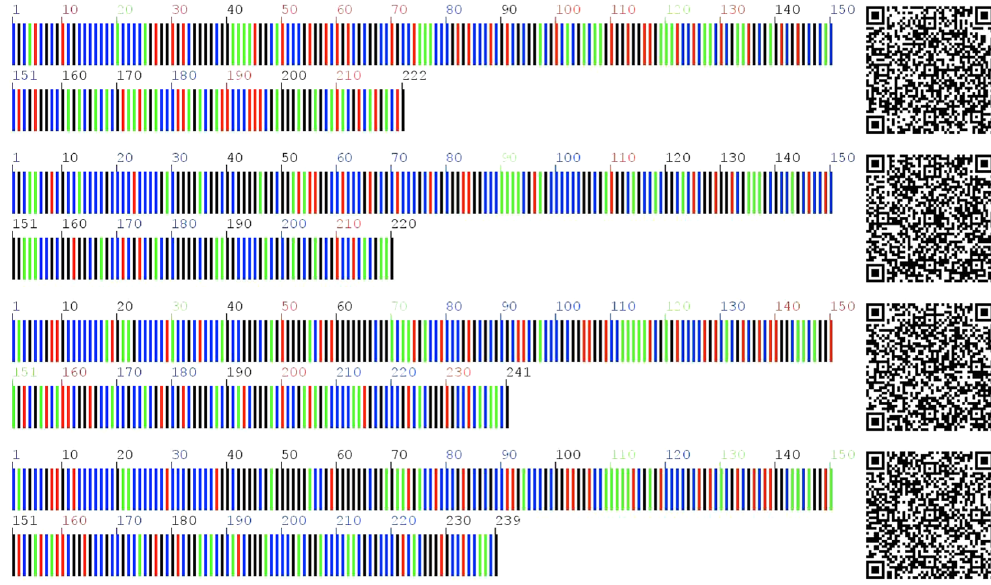
Figure 4. DNA barcoding and two-dimensional DNA barcoding image of ITS2 sequences ( A T C G T . jasminoides 222 bp; E . fortunei 220 bp; F . pumila 239 bp; F . tikoua 241